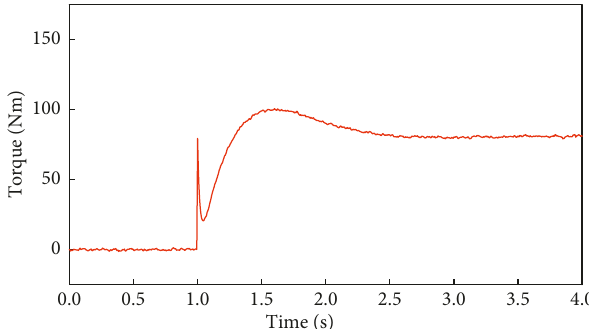
Figure 11: The final output torque with fuzzy switching control.